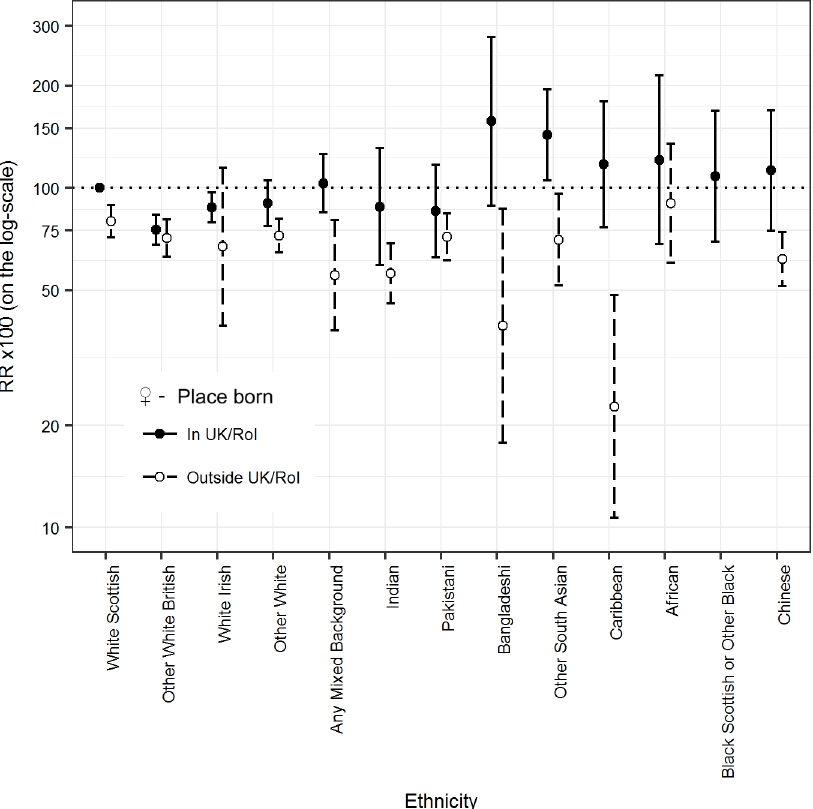
Fig 6. Age-adjusted RRs (bars show 95% CIs) for all-cause mortality by ethnicity and country of birth (UK/RoI born or not) in females. RR, rate ratio; UK/RoI, United Kingdom or Republic of Ireland.